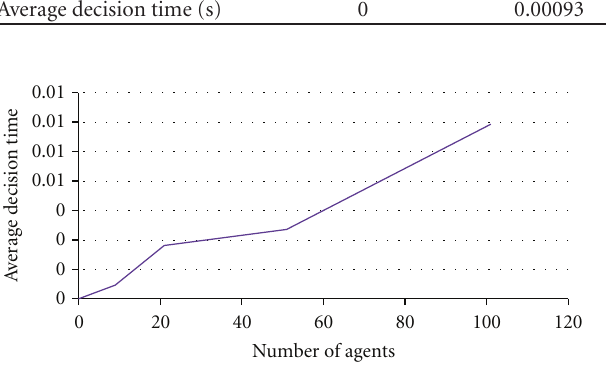
Figure 14: Scalability test results for the SAP hierarchical learning framework: plot of average decision time versus number of agents. The average time required for decision making is plotted against the number of agents. The decision time increases roughly linearly with the number of